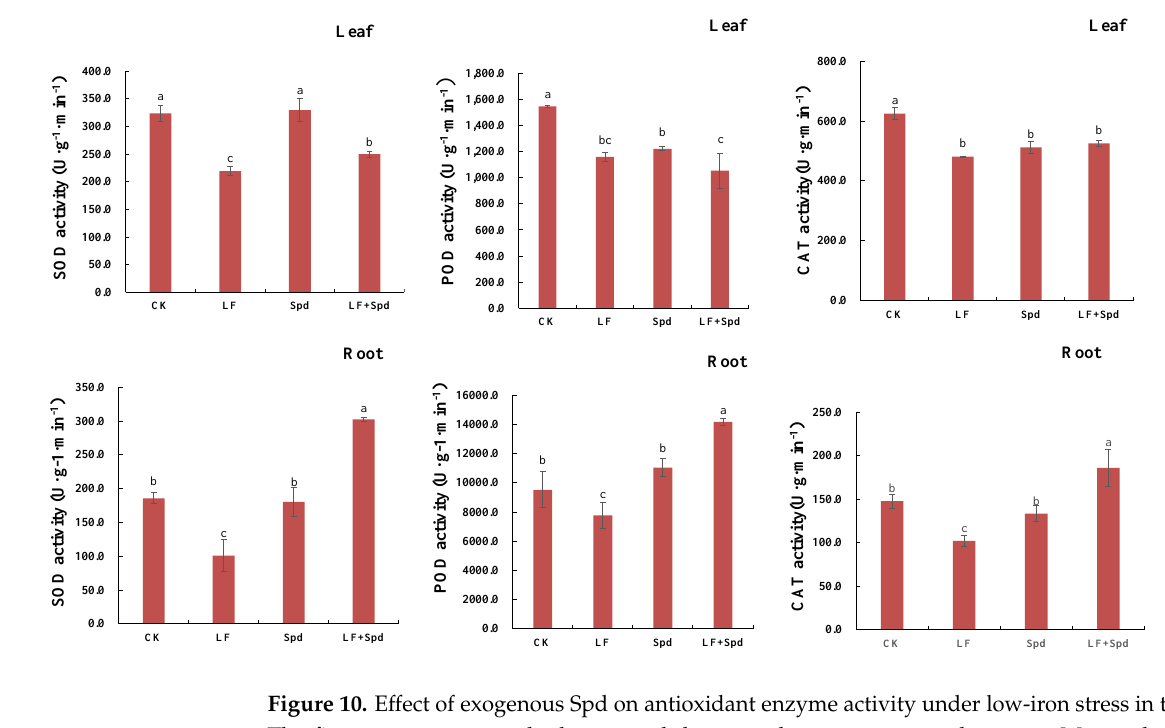
Figure 10. Effect of exogenous Spd on antioxidant enzyme activity under low-iron stress in tomatoes. The first row represents the leaves and the second row represents the roots. Means denoted by the different lower case letters are significantly different according to Duncan’s multiple range test ( p ≤ 0.05); the mean represents the average of three replicates and the vertical bar indicates ± standard